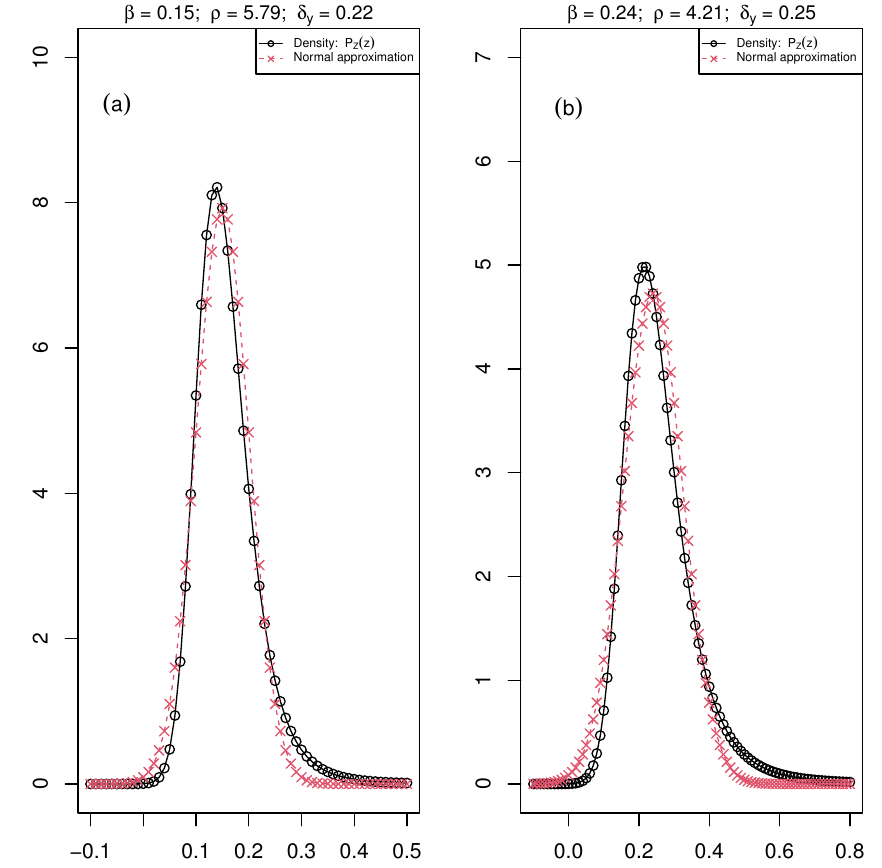
Figure 3. The distribution PZ of the ratio F v / F m ( F m maximum fluorescence and F v = F m − F 0 , F 0 minimum fluorescence) is the black curve with circle points, and the normal approximation is the red curve with crossed points. The parameters β , ρ , and δ y of the distribution PZ are associated with the mean value of these parameters over the six days of the acquisition of chlorophyll fluorescence images for ( a ) Healthy: β = 0.15, ρ = 5.79 and δ y = 0.22 and ( b ) Diseased: β = 0.24, ρ = 4.21 and δ y = 0.25 plants of the bacteria data set.